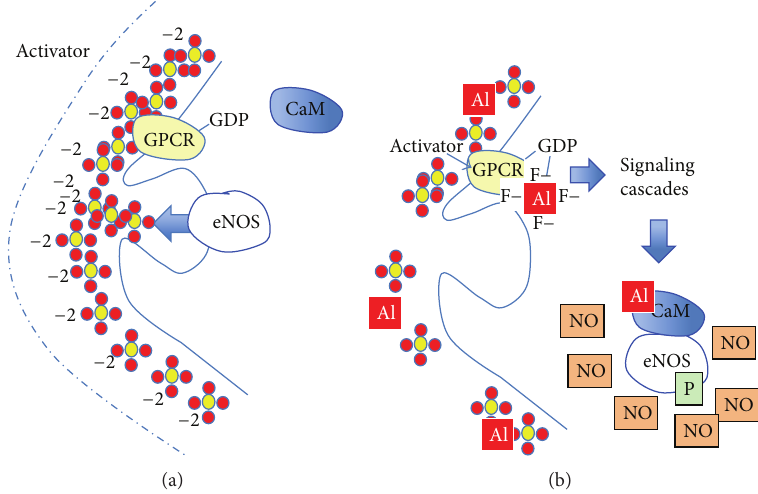
Figure 3: Illustration of the devastating effects of Aluminum on a typical cell related to sulfate inactivation, G-protein signaling, and calmodulin signaling. (a) A healthy cell without Al contamination. eNOS, attached to the membrane at a caveola, produces sulfate, which maintains a healthy glycocalyx with sufficient negative charge. (b) Al binds to the sulfates, eliminating the negative charge, which allows cytokines to penetrate through the glycocalyx, activating G-protein coupled receptor signaling cascades. AlF 4− disrupts the signal, acting as a phosphate mimic, and Al binds to CaM, inducing eNOS detachment from the membrane. Phosphorylation cascades activate eNOS to produce abundant NO released into the cytoplasm, instead of producing sulfate to enrich the